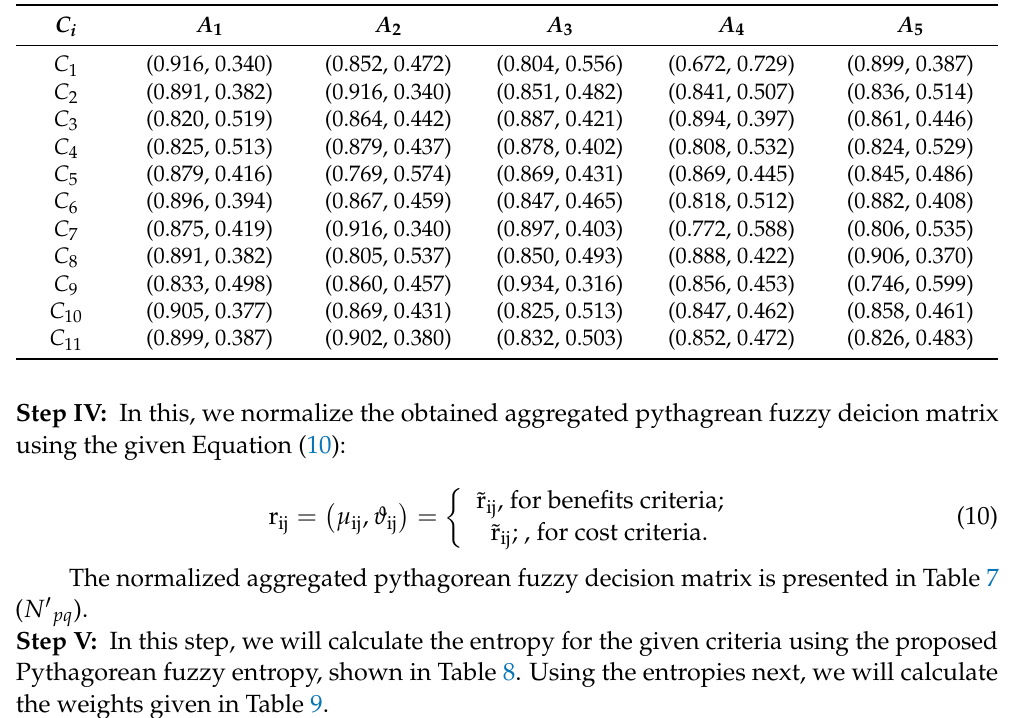
Table 6. Aggregated Pythagorean fuzzy decision